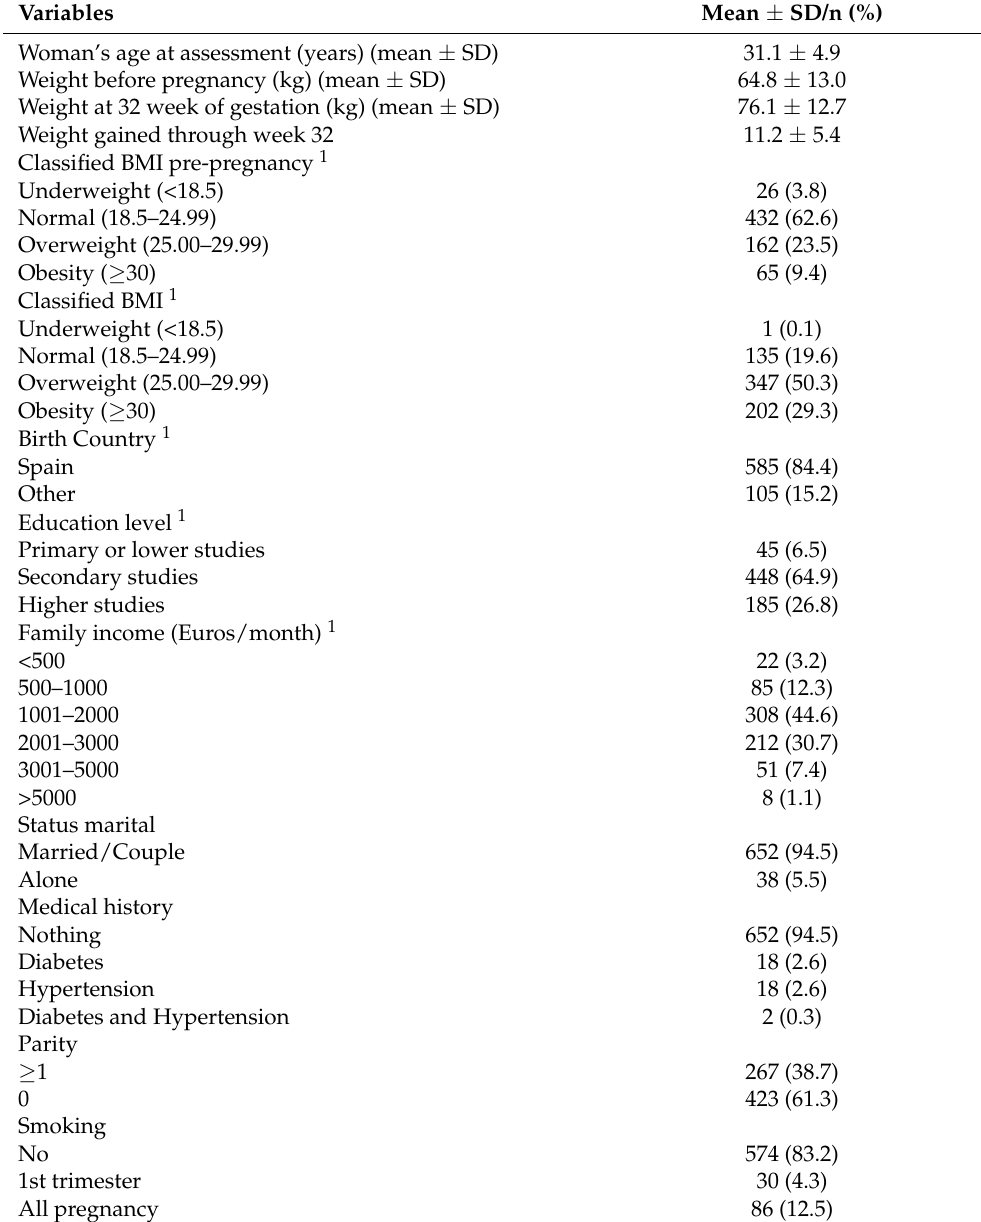
Table 2. Characteristics of participant pregnant women of the GENEIDA study ( n =